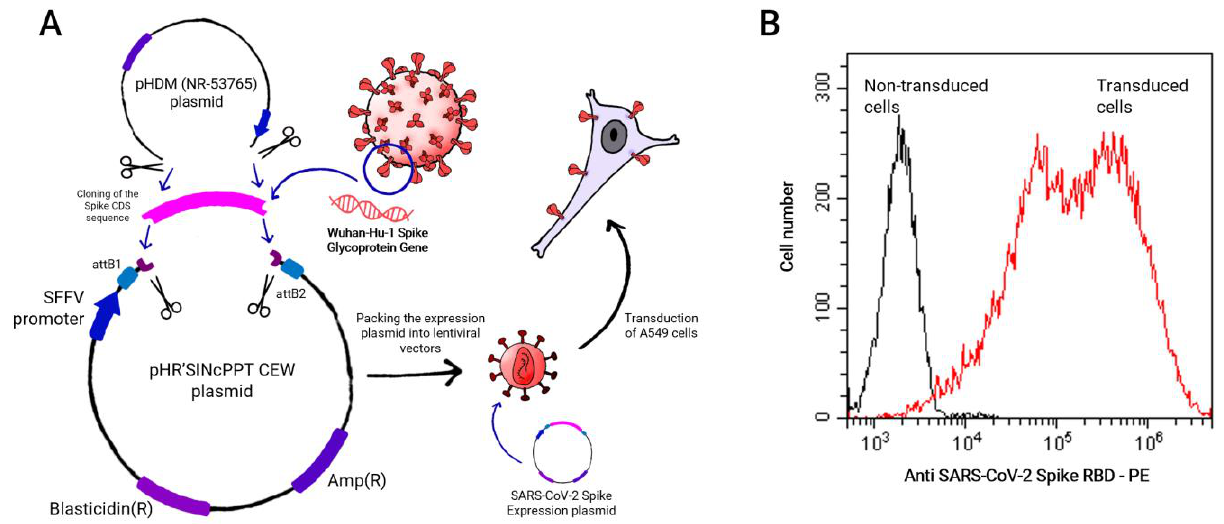
Figure 5. Expression of SARS-CoV-2 spike protein on A549 cells. ( A ) Schematics of SARS-CoV-2 Spike-expressing A549 cells and ( B ) detection, by flow cytometry, of Spike expression of transduced A549 cells.